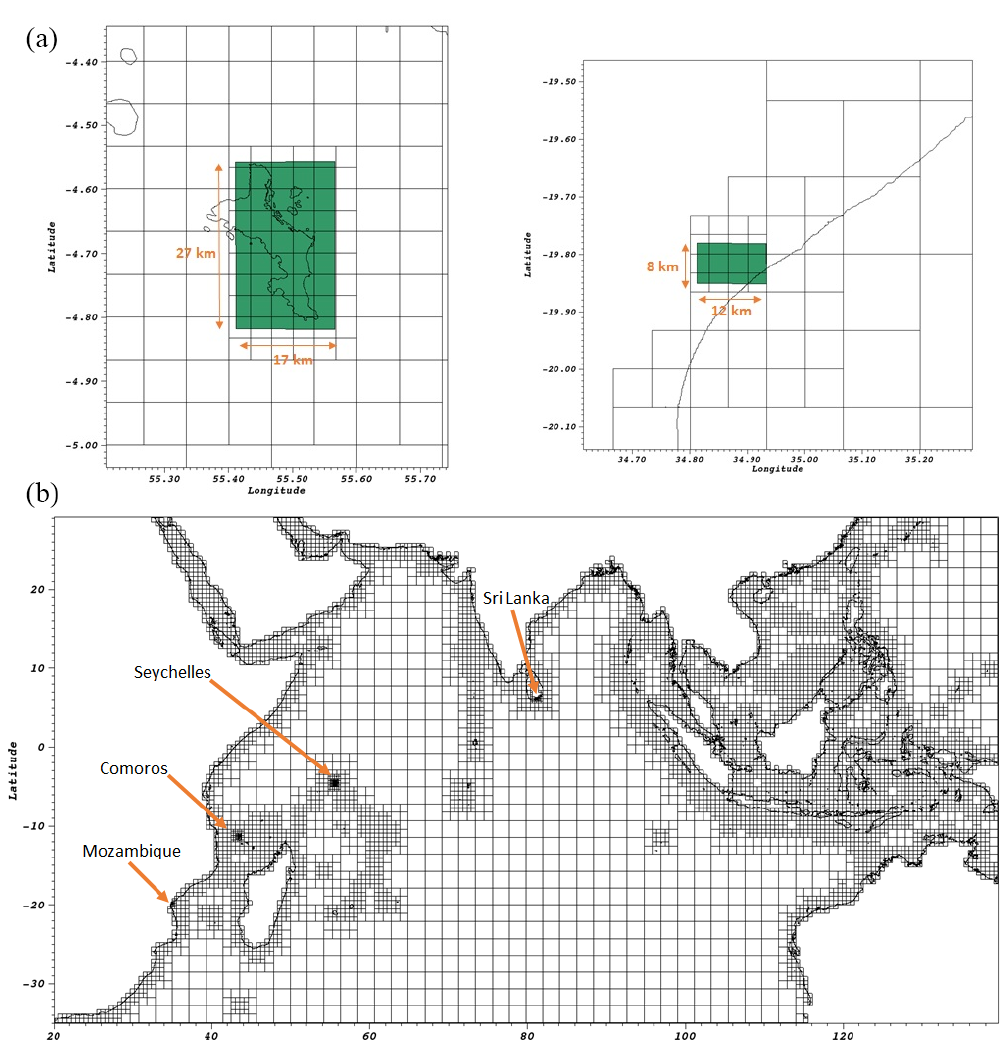
Figure 5. (b) Mesh refinement for Indian Ocean domain with four focal areas (FAs): Mozambique, Comoros, Seychelles and Sri Lanka. (a) Zoom on the Seychelles (right panel) and Sri Lanka (left panel) regions. FAs are highlighted in